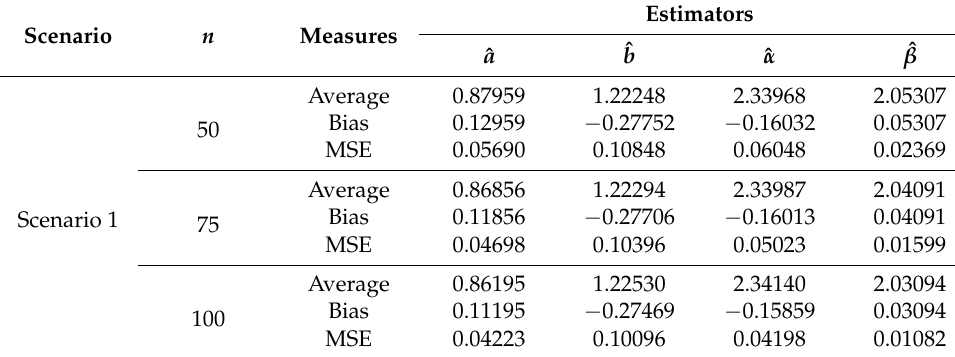
Table 1. Simulation findings for the MLEs of the WBP